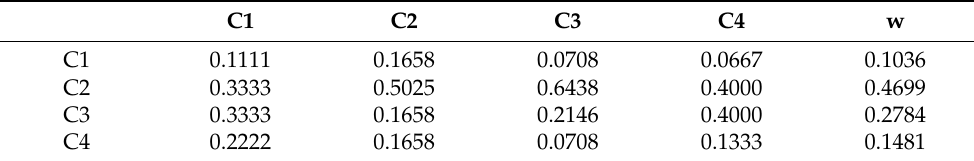
Table 2. Matrix B normalized.